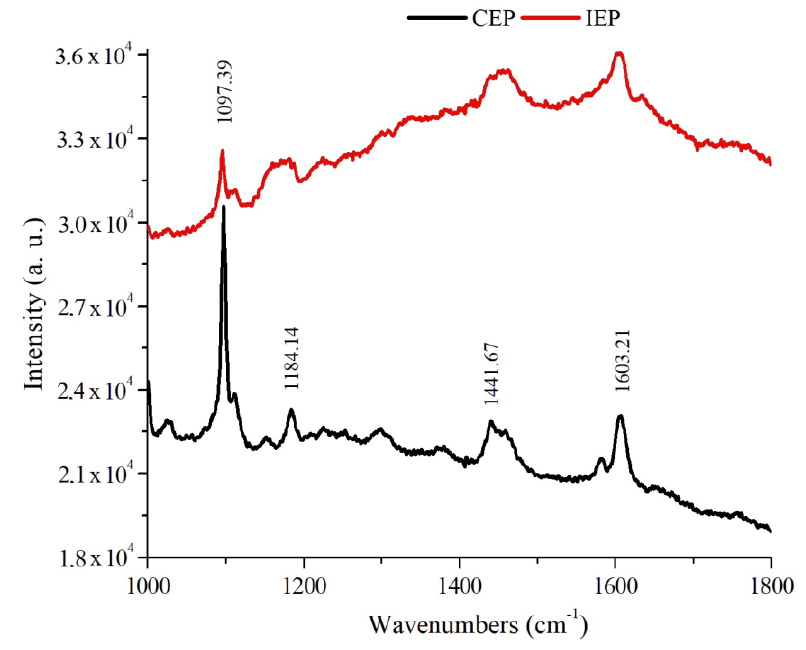
Figure 3. CEP and IEP Raman spectrum. Table 2. Raman spectroscopy for CEP and IEP samples.